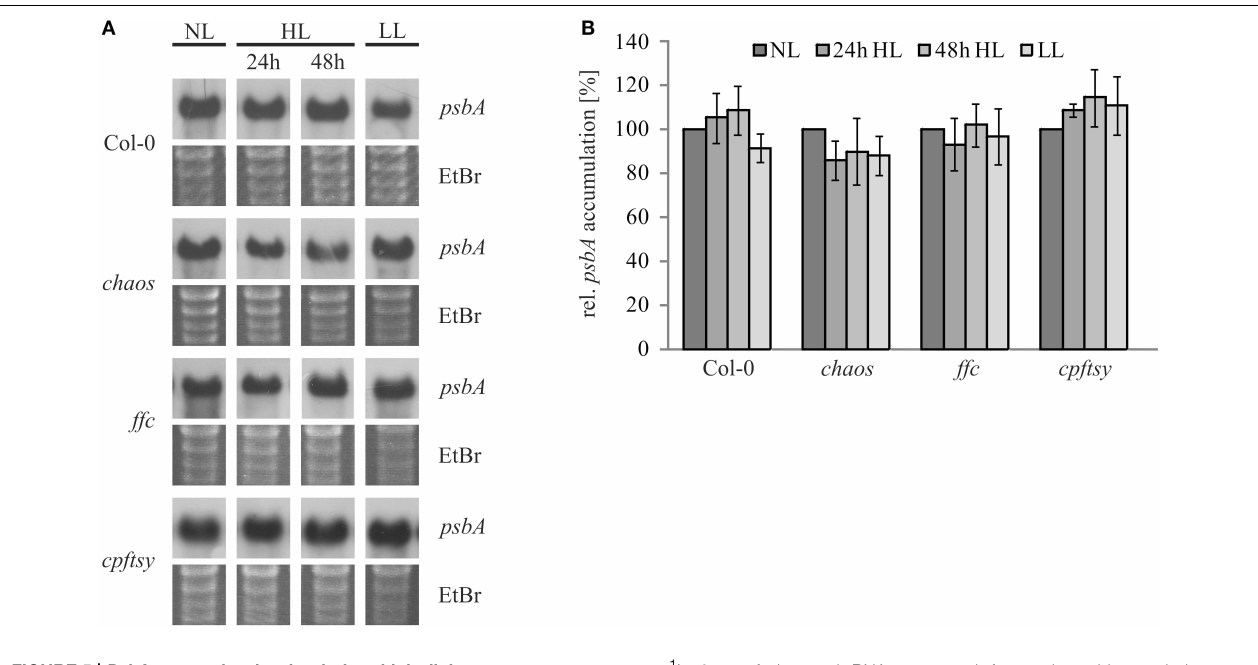
s − 1 ). 3 µ g of the total RNA was used for northern blot analysis to investigate the amount of psbA transcript. As a loading control, gels were stained with ethidiumbromide. (B) Northern blot signals of psbA transcript were quantified using the ImageJ program. The psbA levels at normal light conditions were adjusted to 100%. The error bars indicate the standard deviation ( n = 3